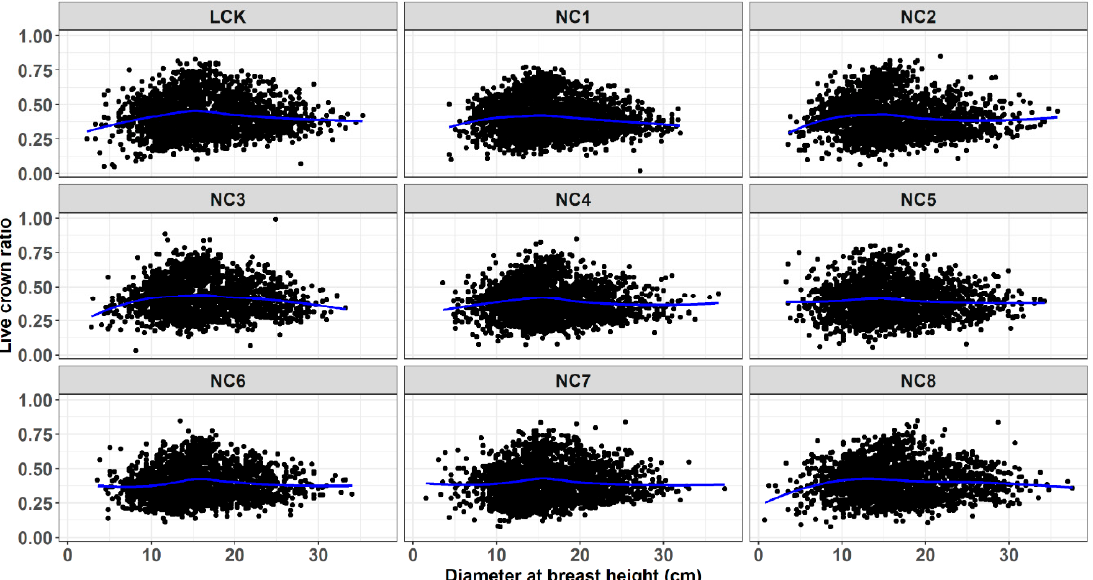
Figure 1. Relationship between live crown ratio (LCR) and dbh for different families of loblolly pine. There is no obvious trend in LCR-dbh relationship for any family used in this study. This trend was consistent when plotted by family and spacing.